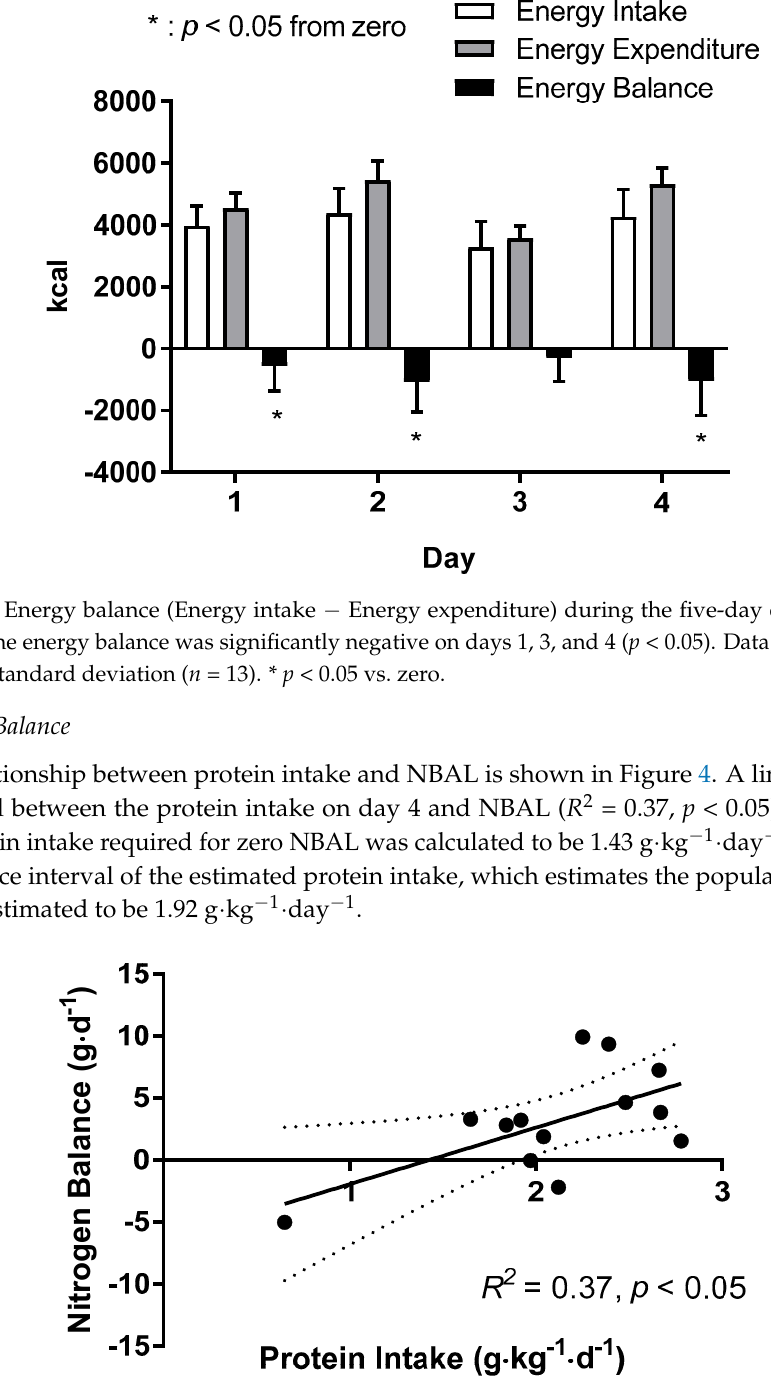
Figure 4. Relationship between nitrogen balance and protein intake.